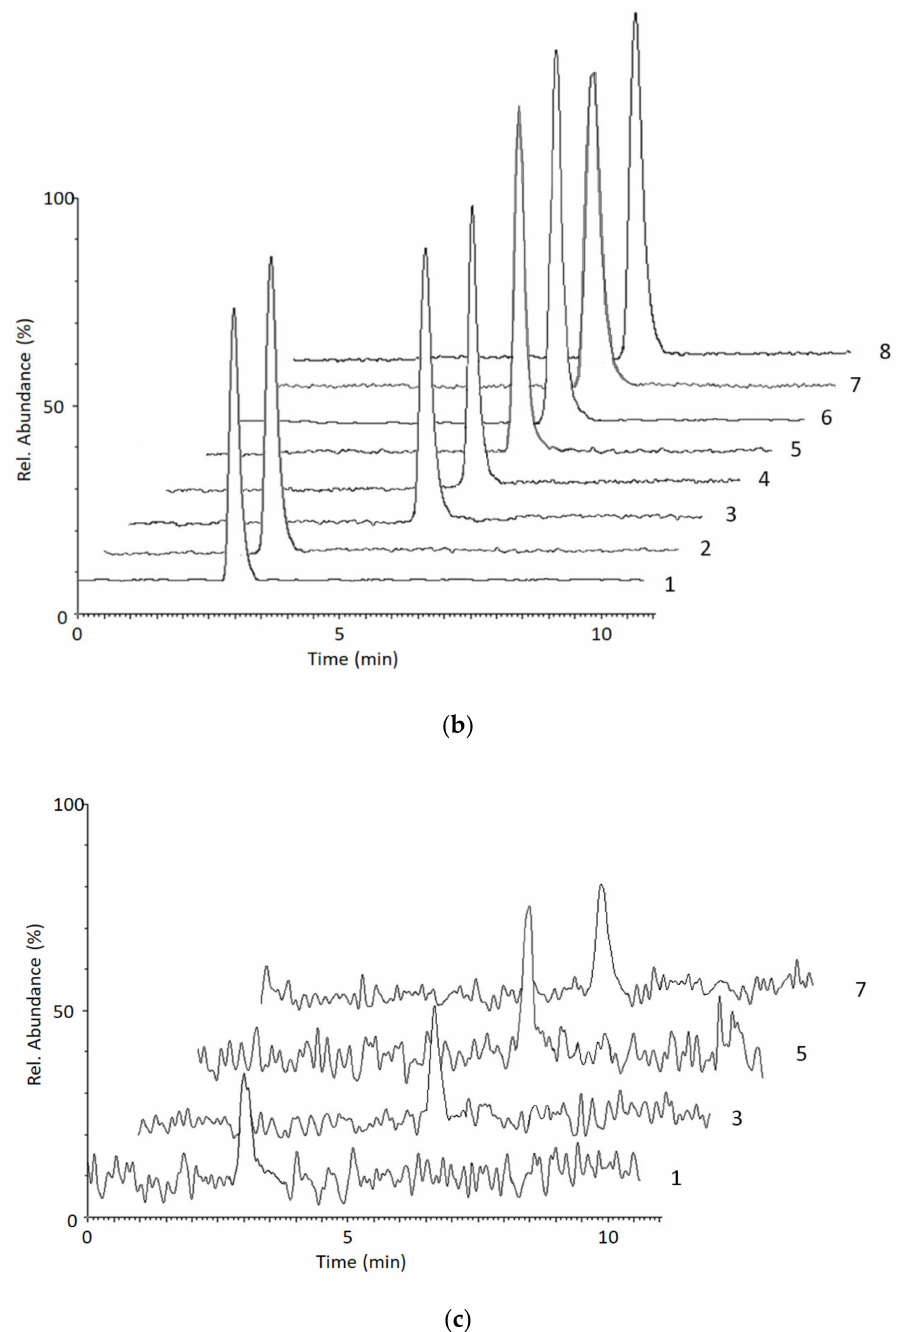
Figure 2. LC-MS / MS chromatograms of ( a ) a blank whole blood VAMS sample; ( b ) a blank plasma VAMS sample spiked with the analytes and the ISs at the concentration of 50 ng / mL; ( c ) a blank plasma VAMS sample spiked with the analytes at the limit of quantitation (LOQ) values: 1—EME; 2—EME-D 3 ; 3—BEG; 4—BEG-D 3 ; 5—COC; 6—COC-D 3 ; 7—CET; 8—CET-D 3